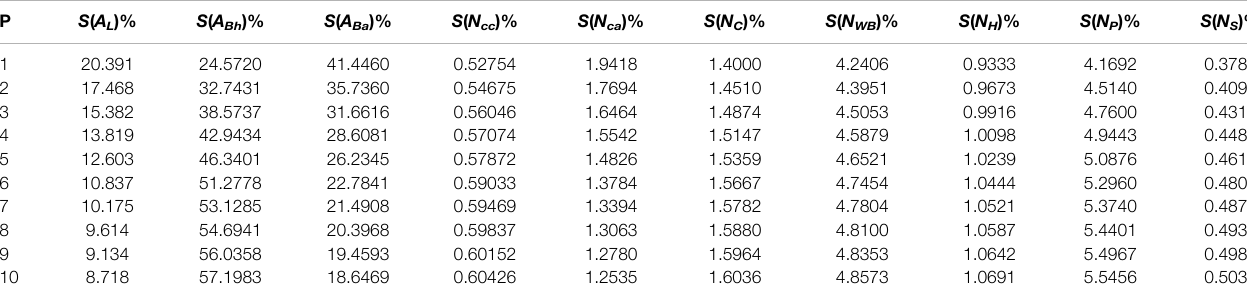
TABLE 4 | Share in the total wealth for different valuable categories as discussed in Section 2.2 .